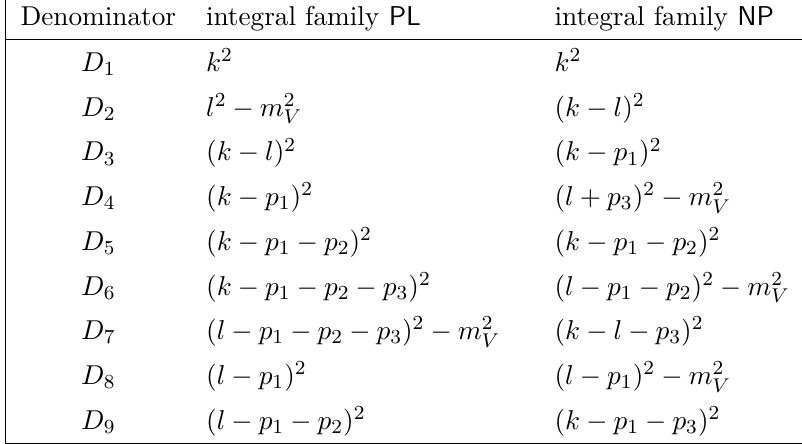
Table 1. Definition of the planar ( PL ) and non-planar ( NP ) integral families. The loop momenta are denoted by k and l , while m V indicates the mass of the vector boson. The prescription +i (cid:15) is understood for each propagator and not written